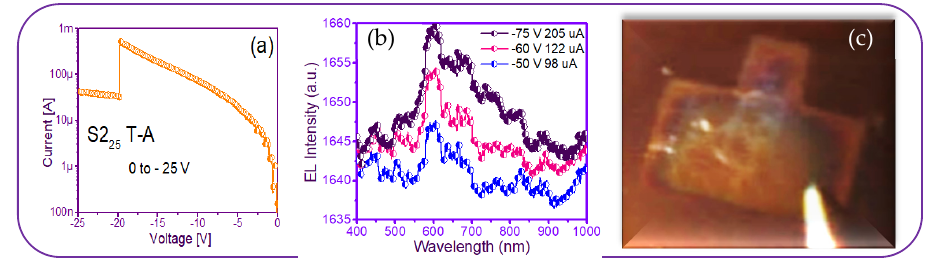
Figure 13. T-A S2 25 structure ( a ) I-V curve, ( b ) EL intensity curves, and ( c ) image of the device showing a weak EL emission.